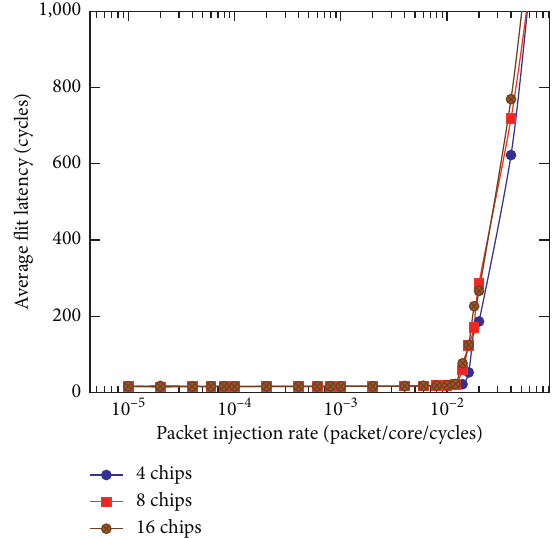
Figure 12: The average latency of the proposed THz multichip system for the different number of